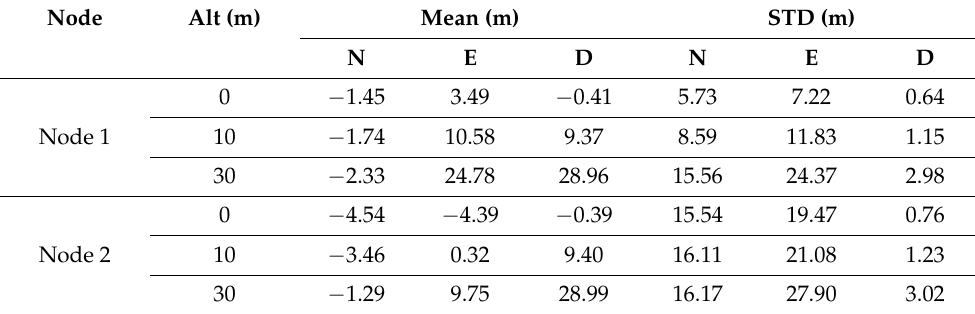
Table 7. Statistics of joint navigation and positioning position error in the altimeter presence scenario.